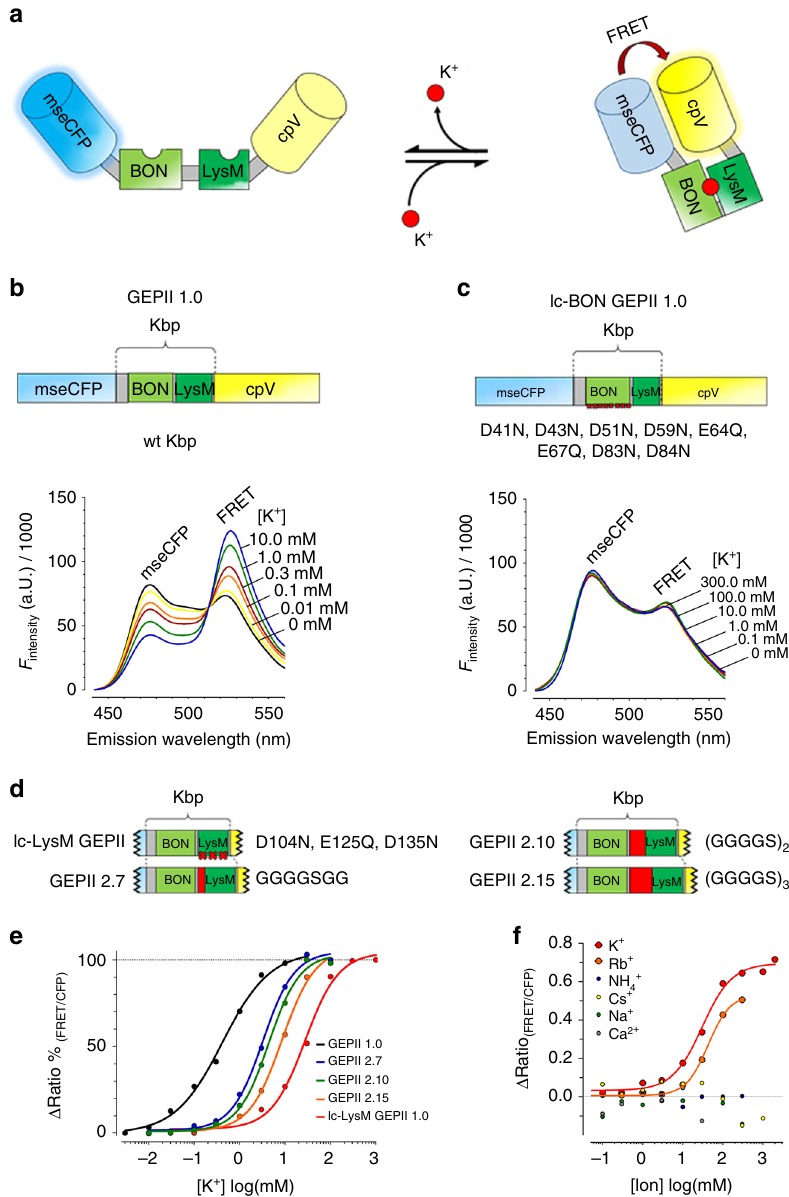
Fig. 1 In vitro characterization of GEPIIs. a Schematic representation of the mechanism of K + sensing by FRET-based GEPIIs. Predicted conformational rearrangement of GEPIIs in the absence and presence of K + . b Scheme (upper panel) and spectral properties (lower panel) of CFP and FRET fl uorescence of puri fi ed GEPII 1.0 at increasing K + concentrations. Puri fi ed GEPII 1.0 was excited at 413.4 ± 8 nm. c Scheme (upper panel) and emission spectra (lower panel) of the K + -insensitive lc-BON GEPII 1.0 in vitro. d Schematic overviews of differently mutated and engineered GEPIIs. e Normalized EC 50 curves for K + of GEPIIs in vitro ( n = 4 for each construct). f K + selectivity of lc-LysM GEPII 1.0 ( n = 3 for each ion). FRET ratio signals are plotted against